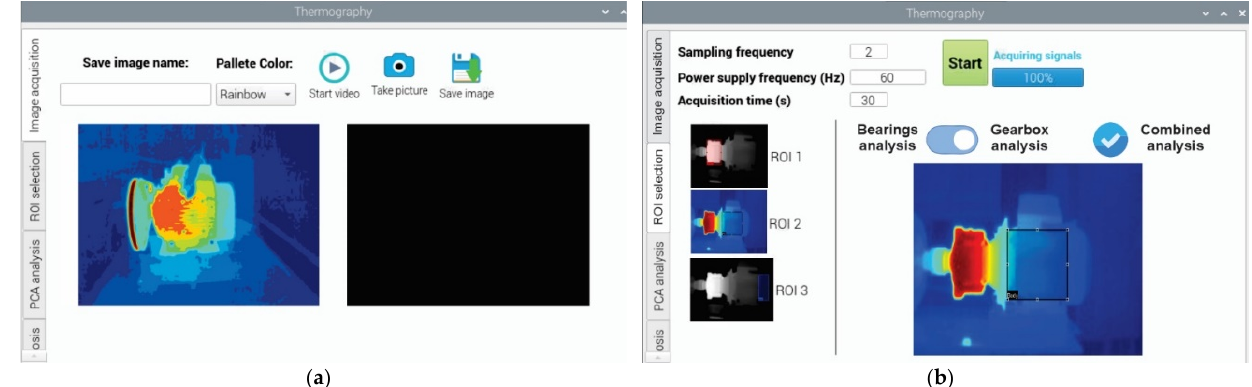
Figure 13. Smart sensor screen templates, in ( a ) Image acquisition tab, and in ( b ) ROI selection tab.